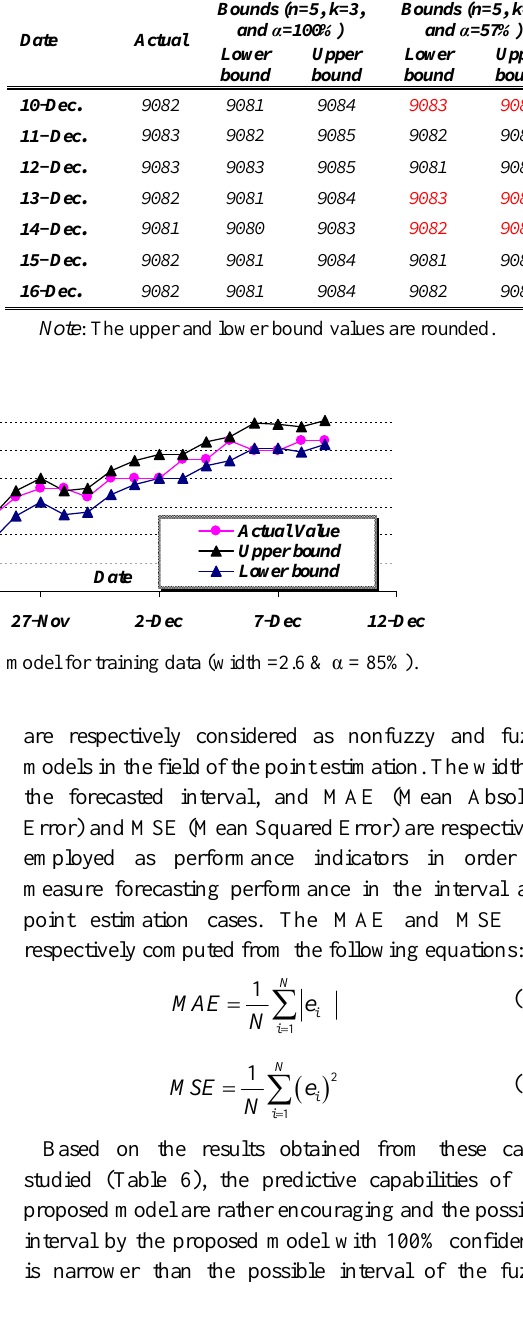
Table 5. Obtained lower and upper bounds by the proposed model for test data set * Bounds (n=5, k=3, and α =100%)